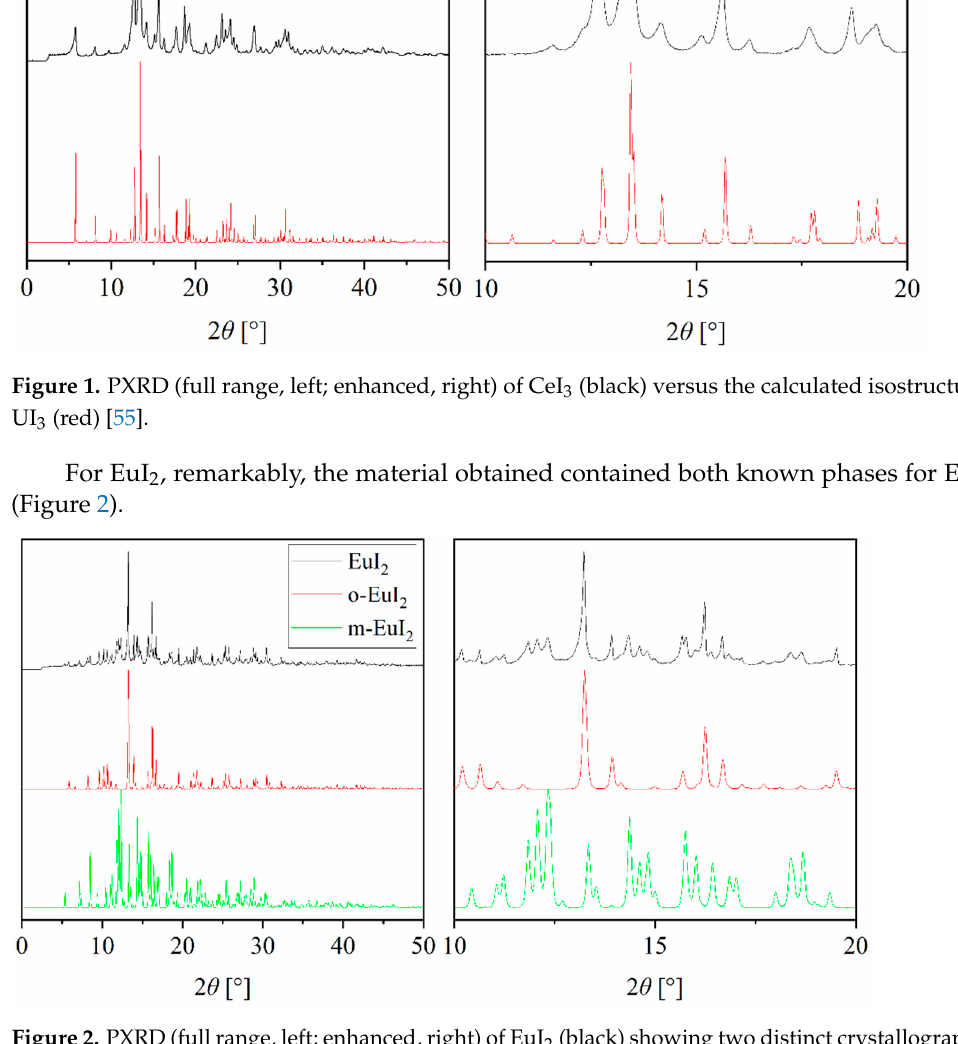
Figure 2. PXRD (full range, left; enhanced, right) of EuI 2 (black) showing two distinct crystallographic phases (orthorhombic, red [35], and monoclinic, green [56]).